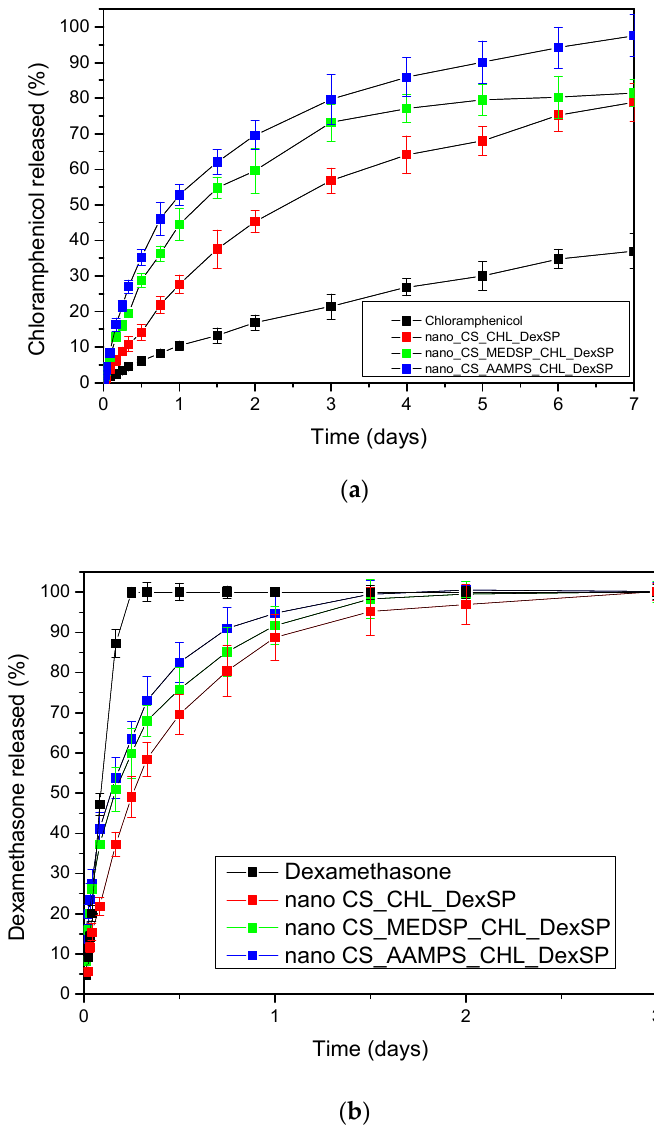
Figure 10. In vitro release of ( a ) CHL and ( b ) DexSP from prepared nanoparticles at pH =